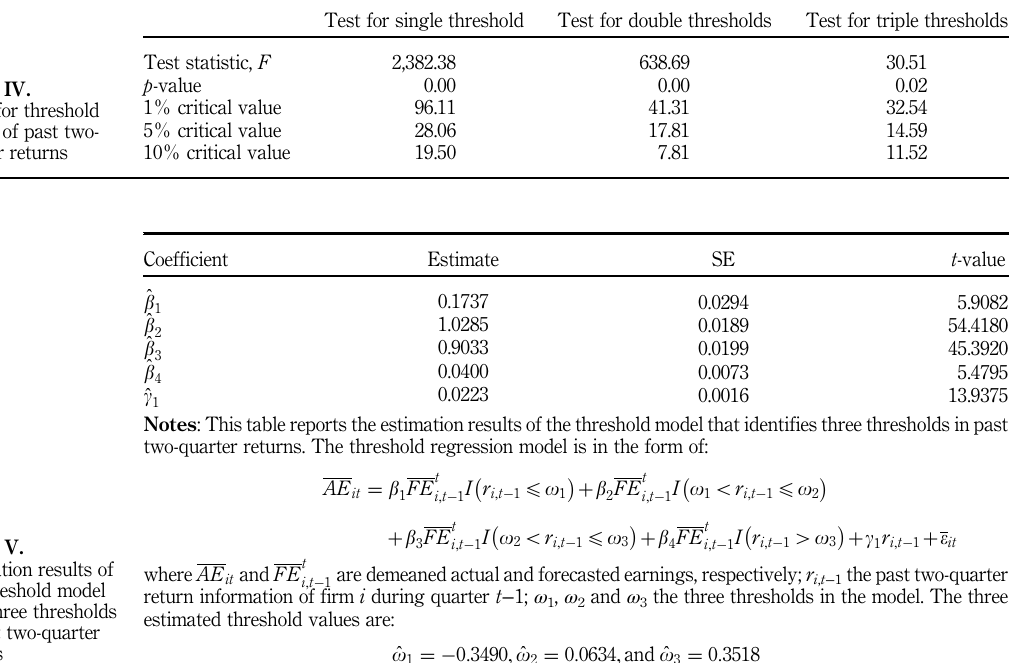
Table V. Estimation results of the threshold model with three thresholds